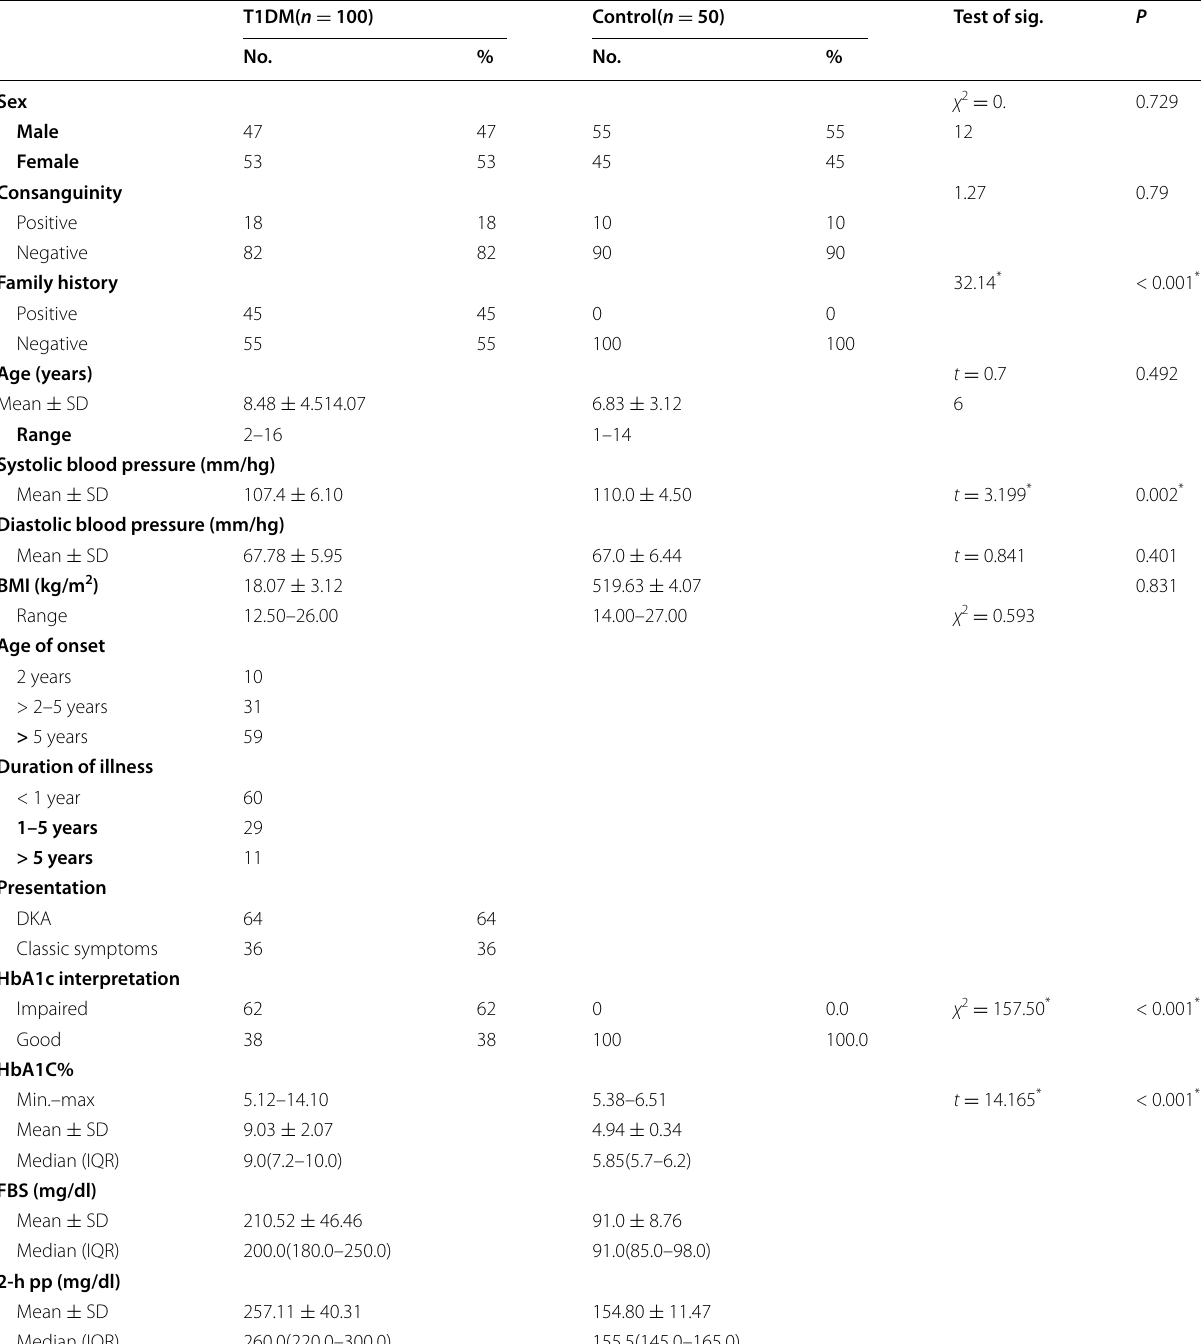
Table 1 Demographic and laboratory data the two studied